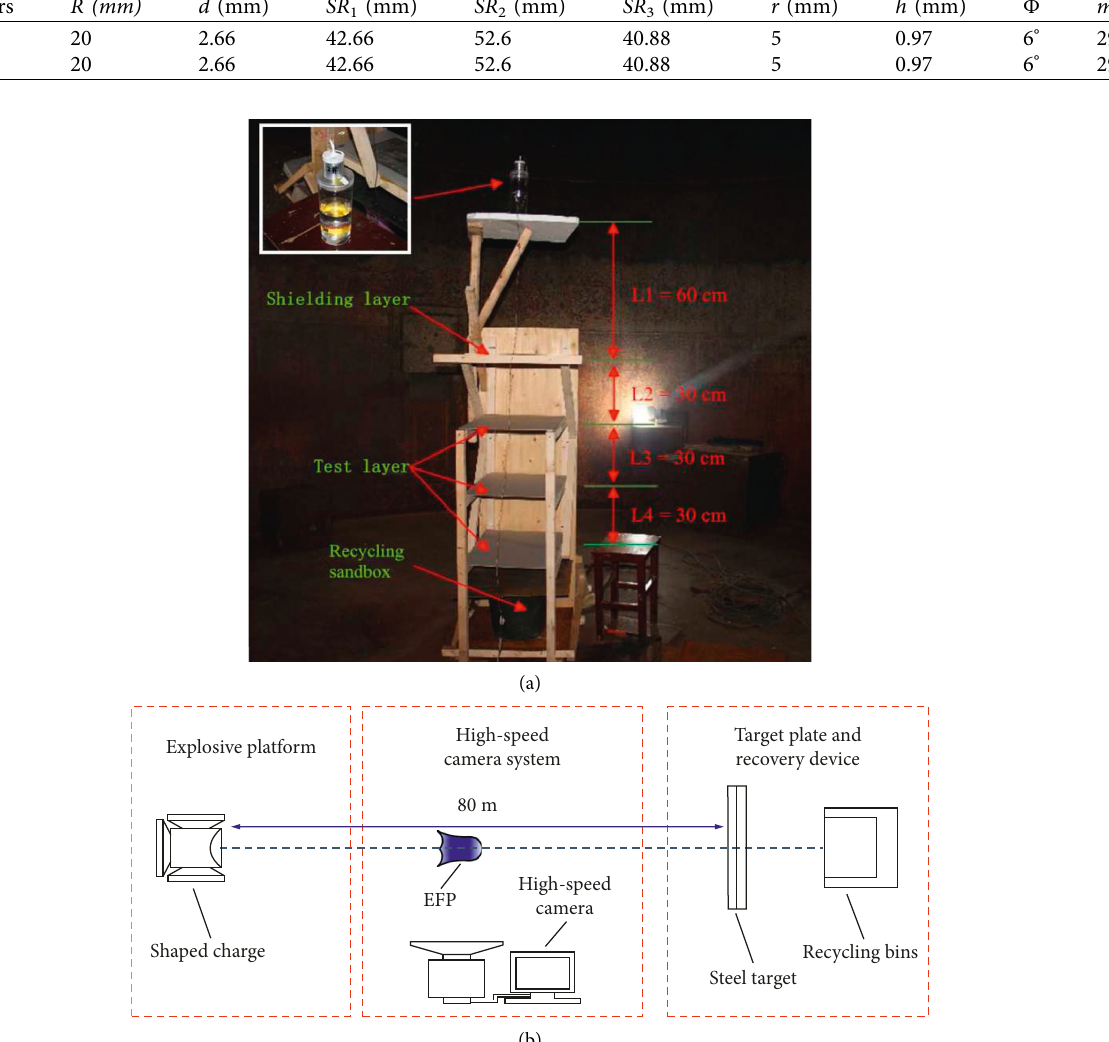
Figure 4: (a) Layout of the explosively formed penetrator (EFP) formation test site. (b) Schematic diagram of the EFP shooting accuracy test